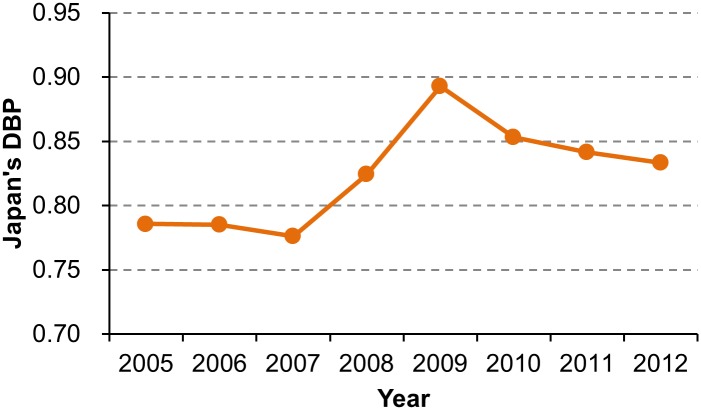
Japan’s DBP between 2005 and 2012.Calculated from the data of Fig 1.